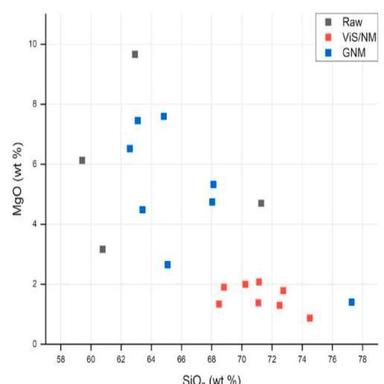
Bivariant plots Na2O versus SiO2; MgO versus SiO2 and CaO versus SiO2 of the raw/low fired, ViS-NM and GNM samples indicating a sodium enrichment towards the glass zone, a magnesium enrichment of the GNM and raw/low fired samples and a slight increase in calcium towards the glass zone (based on data presented in) . (For interpretation of the references to colour in this figure legend, the reader is referred to the Web version of this article.)